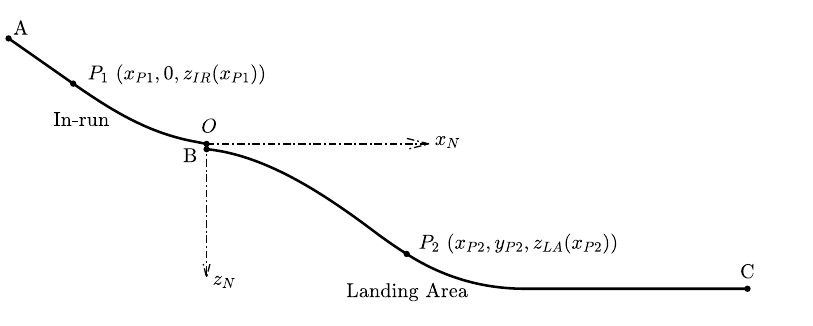
Figure 4. The Longitudinal Profile of a Ski Jumping